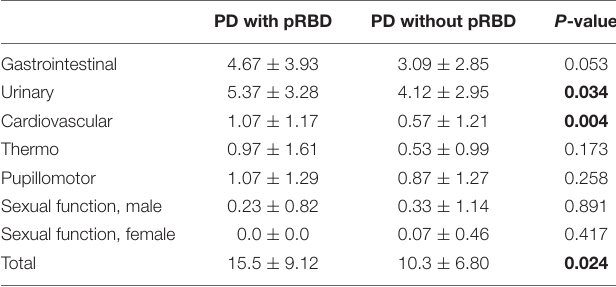
TABLE 3 | Comparison of SCOPA-AUT domains between PD patients with and without